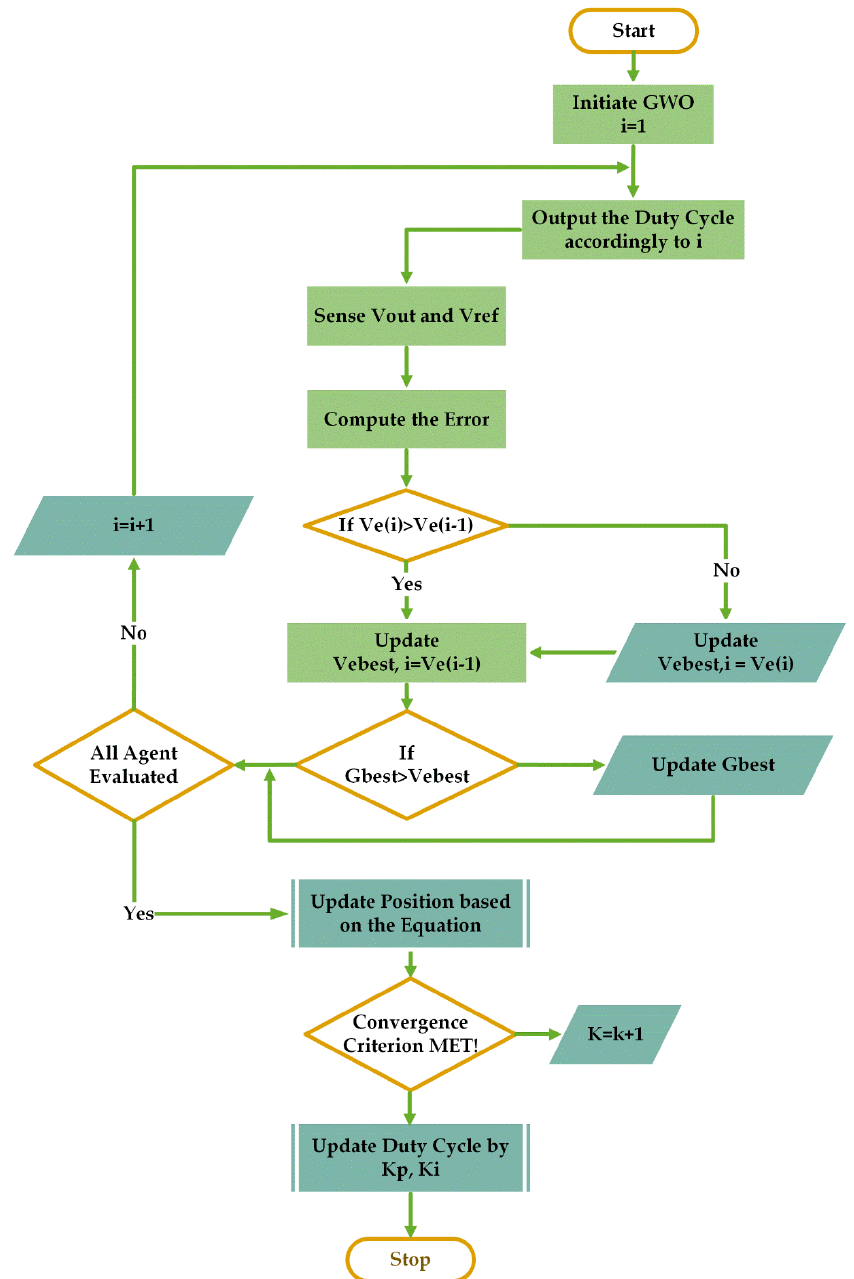
Figure 3. Flow chart of the Grey Wolf Optimizer (GWO)-based Maximum Power Point Tracking (MPPT) algorithm.